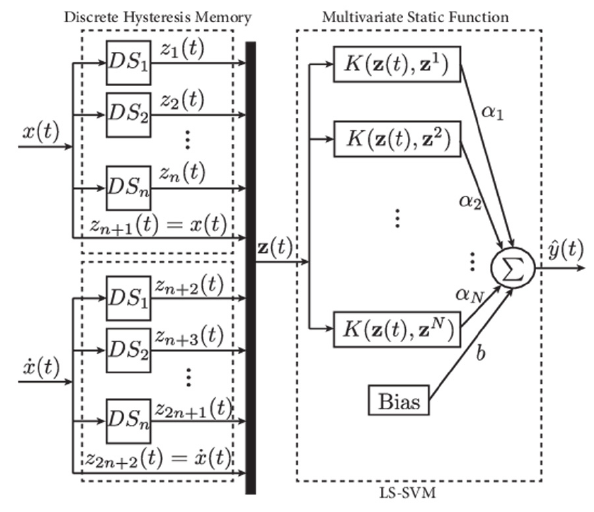
Figure 3. ELM − SVM hysteresis model architecture for rate − independent hysteresis.